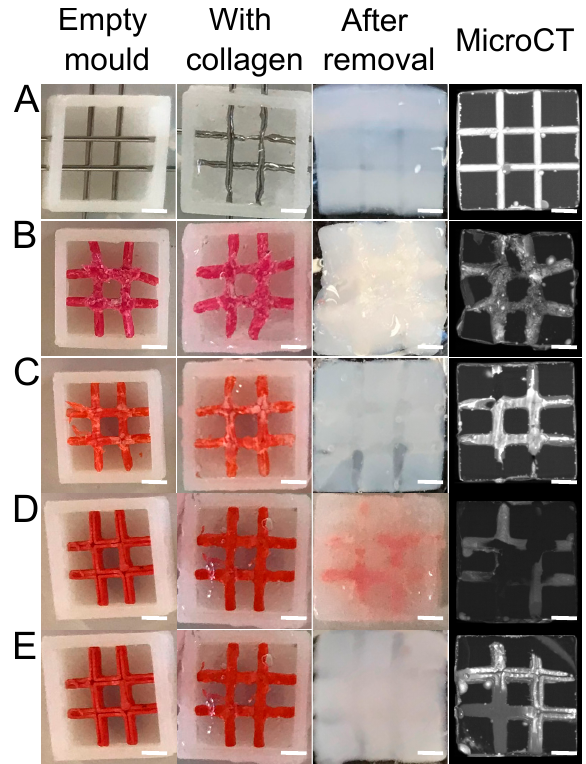
Figure 3. Screening of the different thermoplastics used as a sacrificial matrix. ( A ) Needles, ( B ) ABS, ( C ) PLA, HIPS without ( D ) and with ( E ) dichloromethane injection. Scale bar: 2 mm.